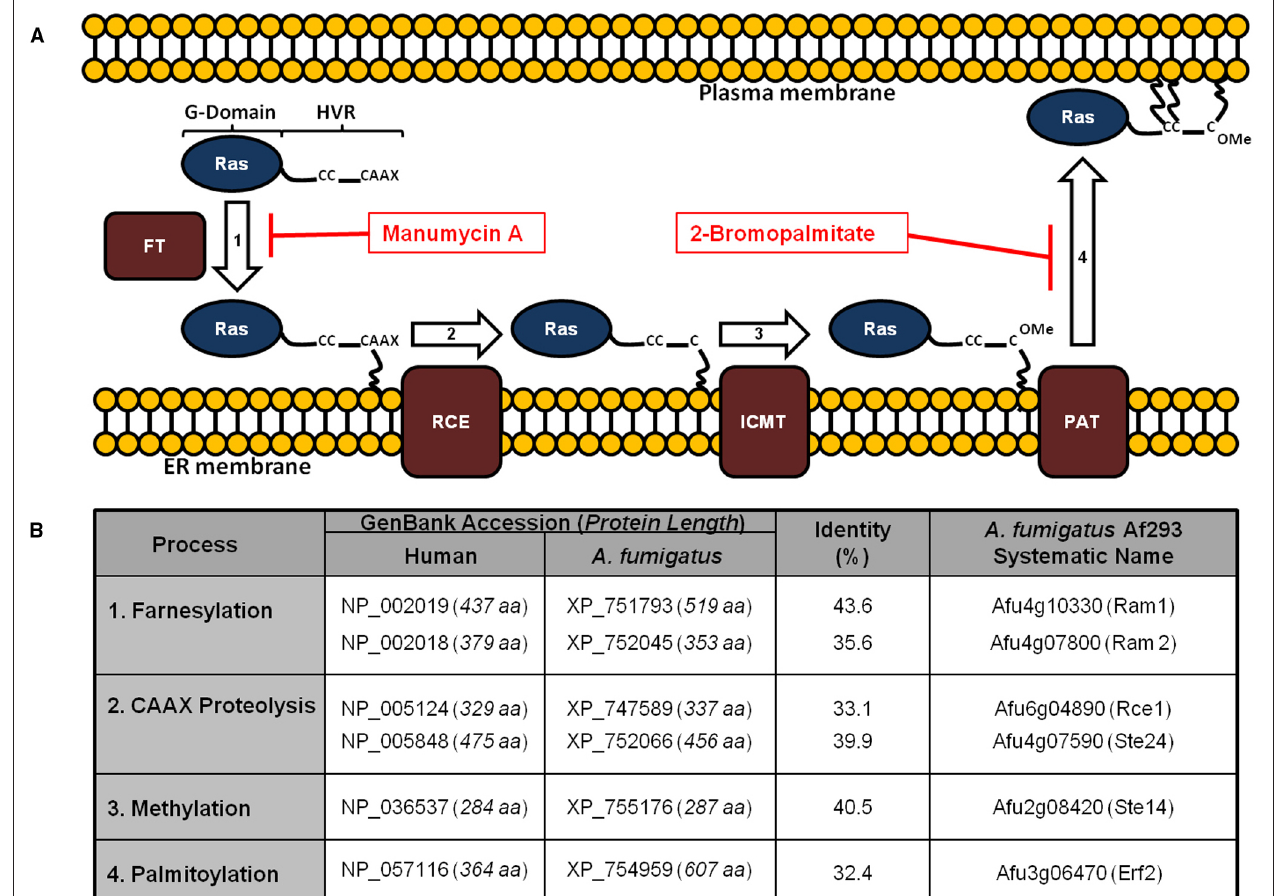
A. fumigatus include manumycin A and 2-bromopalmitate, targeting farnesylation and palmitoylation, respectively. FT = farnesyltransferase; RCE = Ras converting enzyme; ICMT = isoprenylcysteine carboxymethyltransferase; PAT = palmitoyltransferase. (B) Homologs of the protein components of the Ras post-translational modification pathway are shown. Protein lengths in amino acids (aa) are included with the GenBank accession numbers. Identity (%) was determined using protein alignments in Lasergene software (DNAstar). For reference, homologs of the yeast pathway are given in parentheses next to the A. fumigatus Af293 systematic name (right